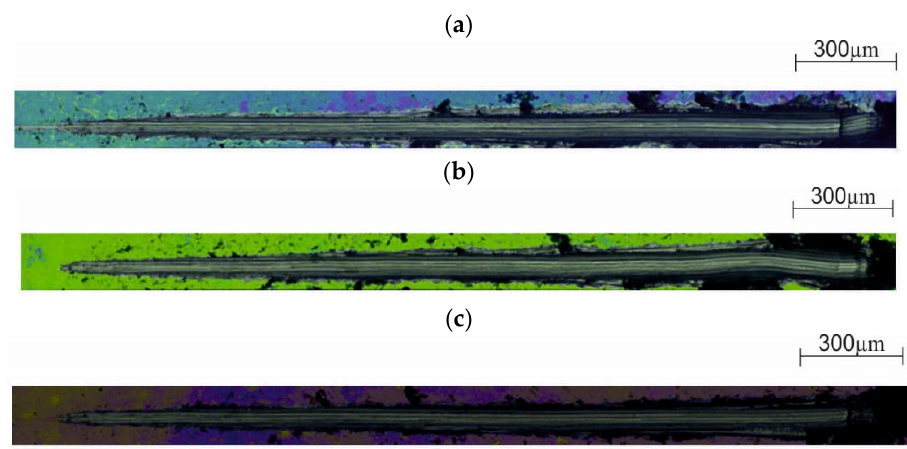
Figure 15. Results of the adhesion tests for the ZnO layer deposited at 1500 cycles (electropolished): ( a ) 100 °C, ( b ) 200 °C, ( c ) 300 °C.